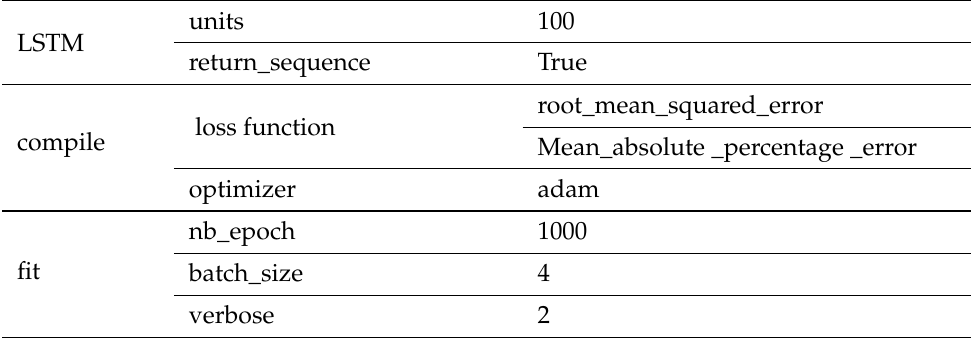
Figure 5. Box plot and seasonality of the real inventory data. Table 1. LSTM model